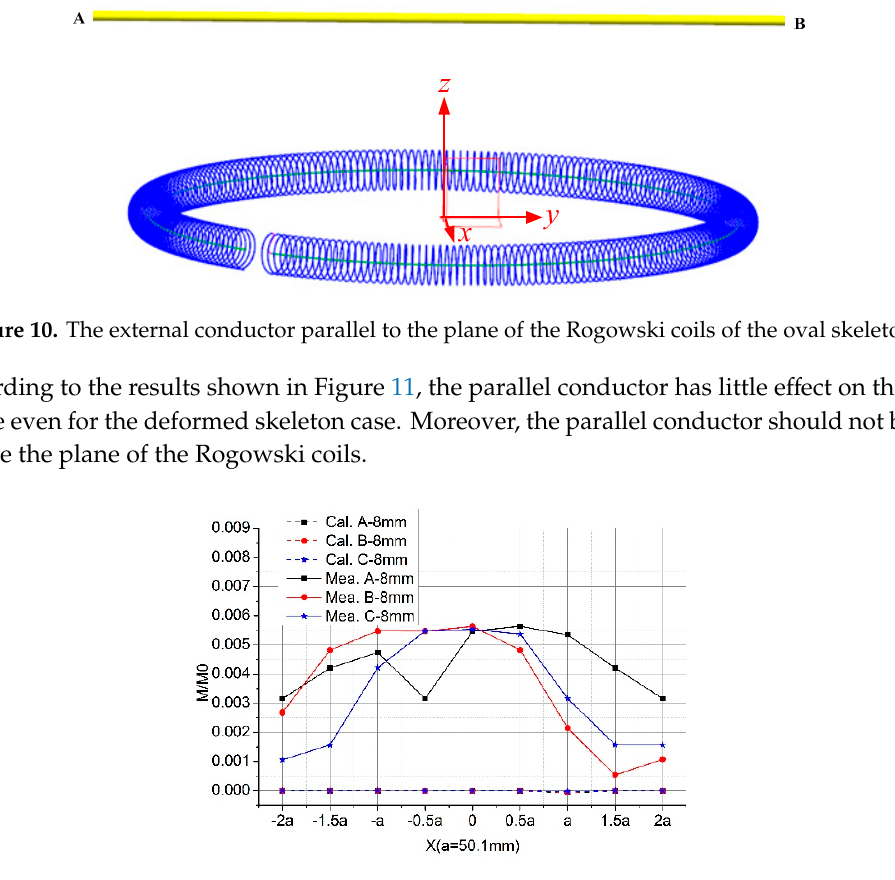
Figure 11. Normalized mutual inductance vs. position primary conductor of the when the conductors are parallel to the Rogowski coils plane.